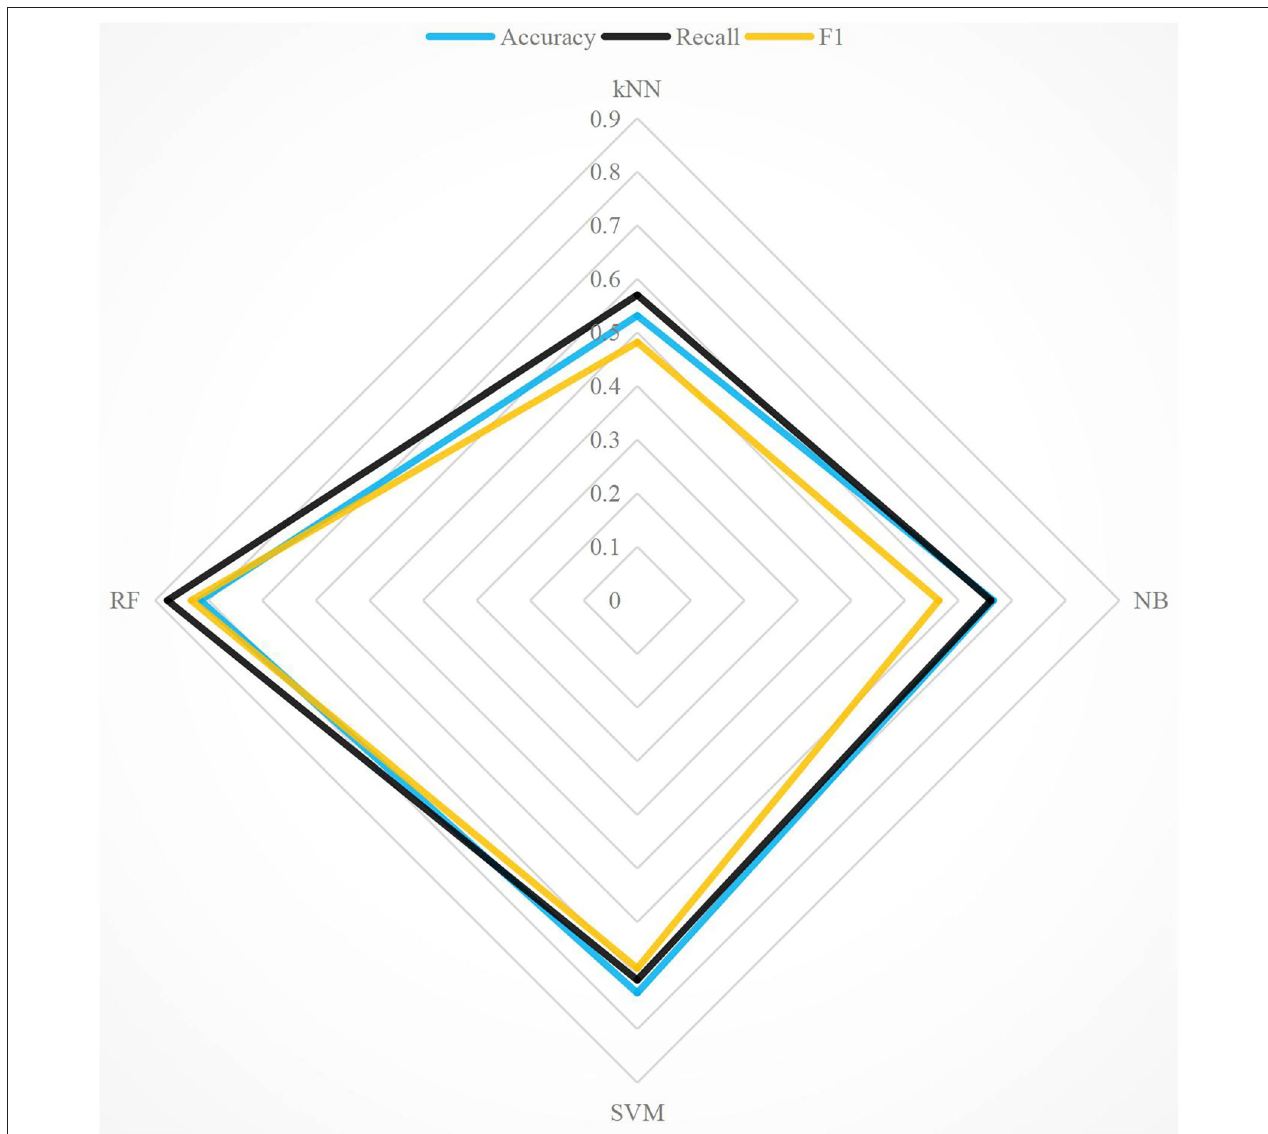
FIGURE 3 | Comparison of evaluation metrics with four methods under extended